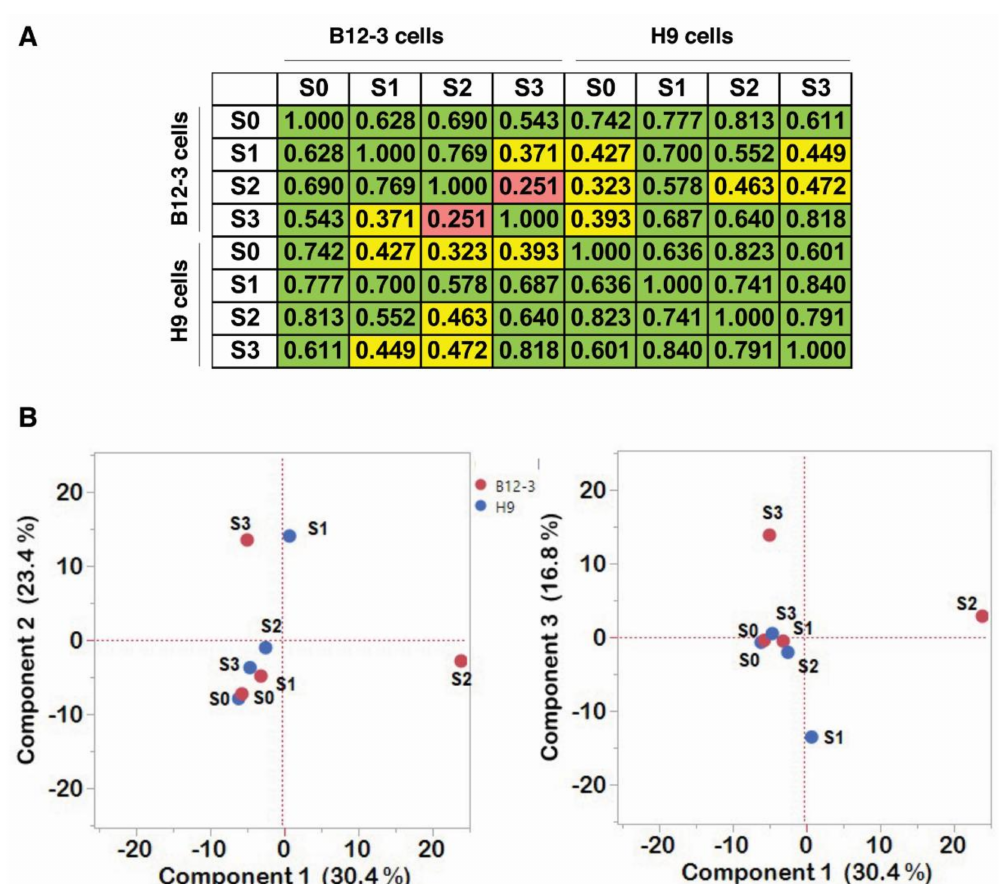
Figure 4. Correlational and dimensional reduction analyses of proteomic content of isolated exosomes. ( A ) Value of the PCC upon pairwise comparison of exosomal samples from different stages of differentiation. ( B ) PCA of all available datasets in this study. The first three PCs are shown. Numbers in parentheses show the variance attributed to the respective component. The hPSC line from which the exosomes are derived is shown by color: B12-3-red, H9-blue. Stages are indicated by ‘S’ followed by a numeral, e.g., stage 2 is